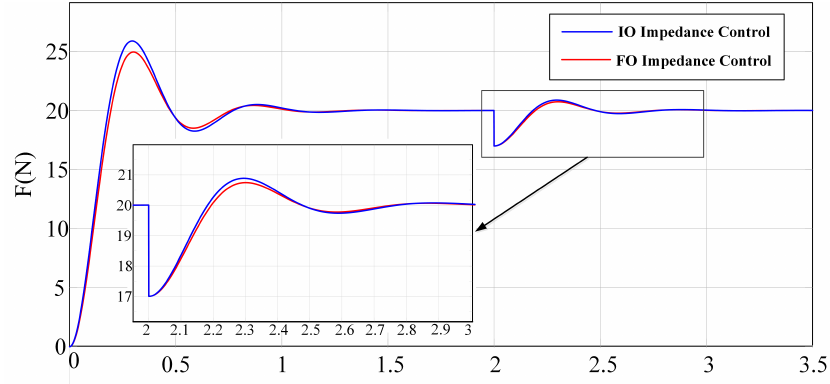
Figure 10. Simulation comparison of FO/IO-impedance